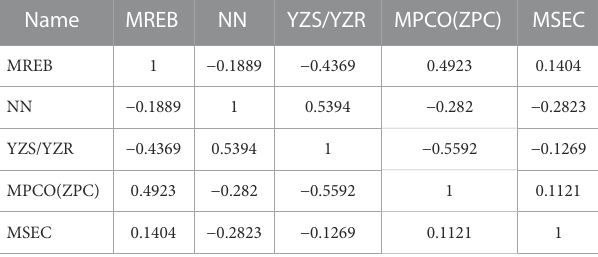
TABLE 3 Correlation coef fi cient between descriptors.